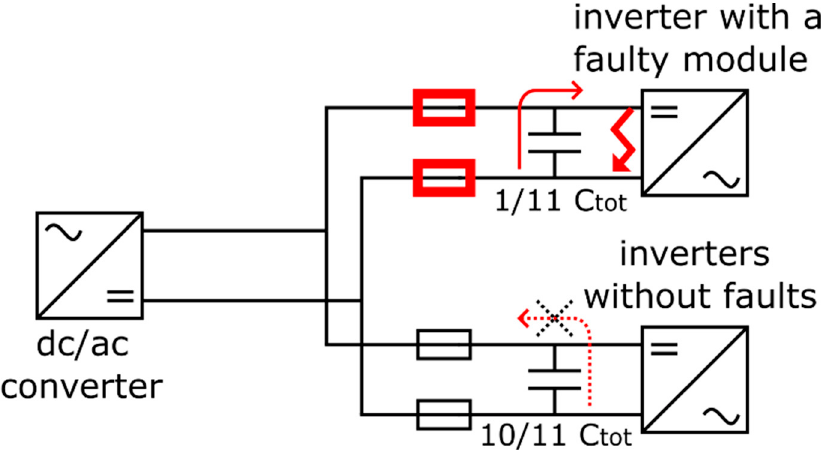
Figure 5. Principle of operation of the protection with fuses.